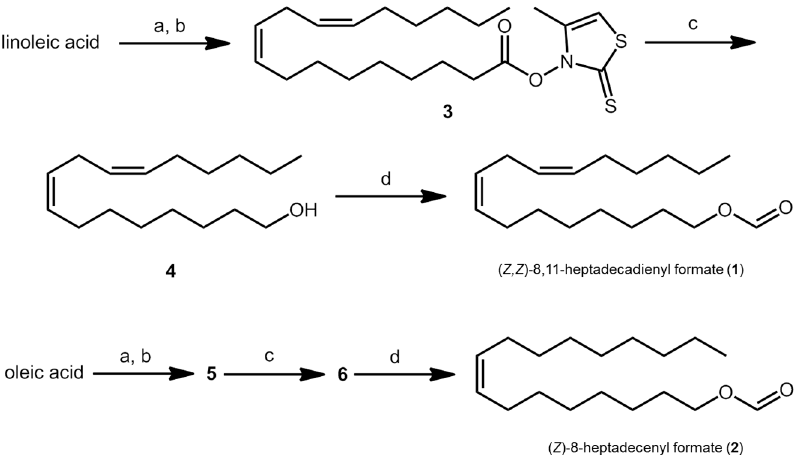
Figure 3. Mass fragmentation of DMDS derivatives derived from ( a ) compound 1 and ( b ) compound 2 . Compounds 1 and 2 were each synthesized in a four-step process, as shown in Scheme 1, with Barton decarboxylation being the key reaction [12,13].